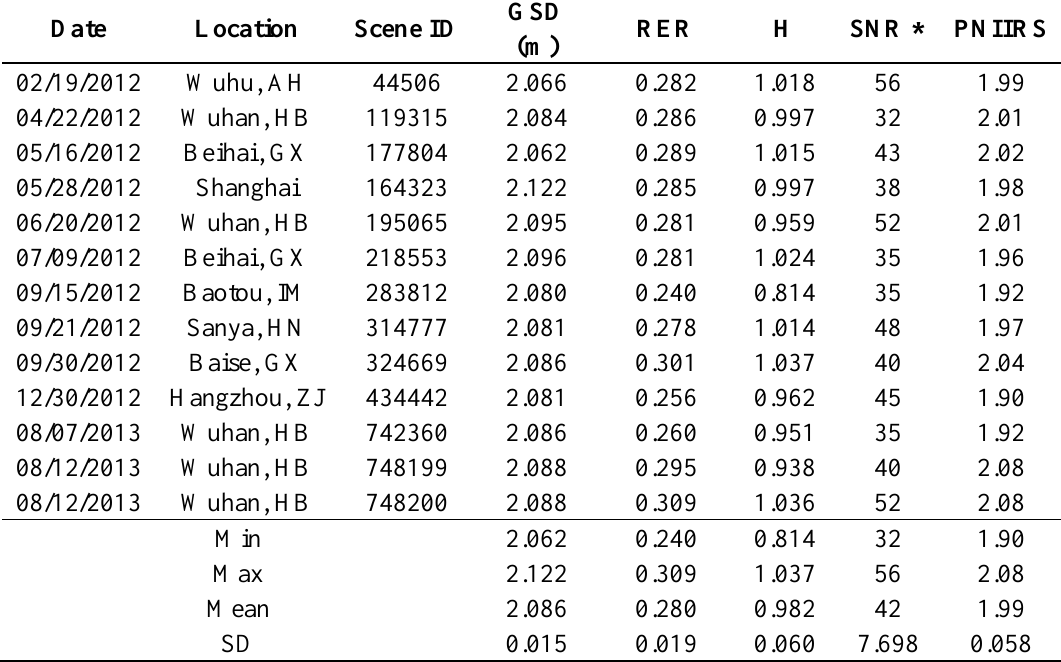
Table 5. Results of the predicted NIIRS (PNIIRS) assessment.